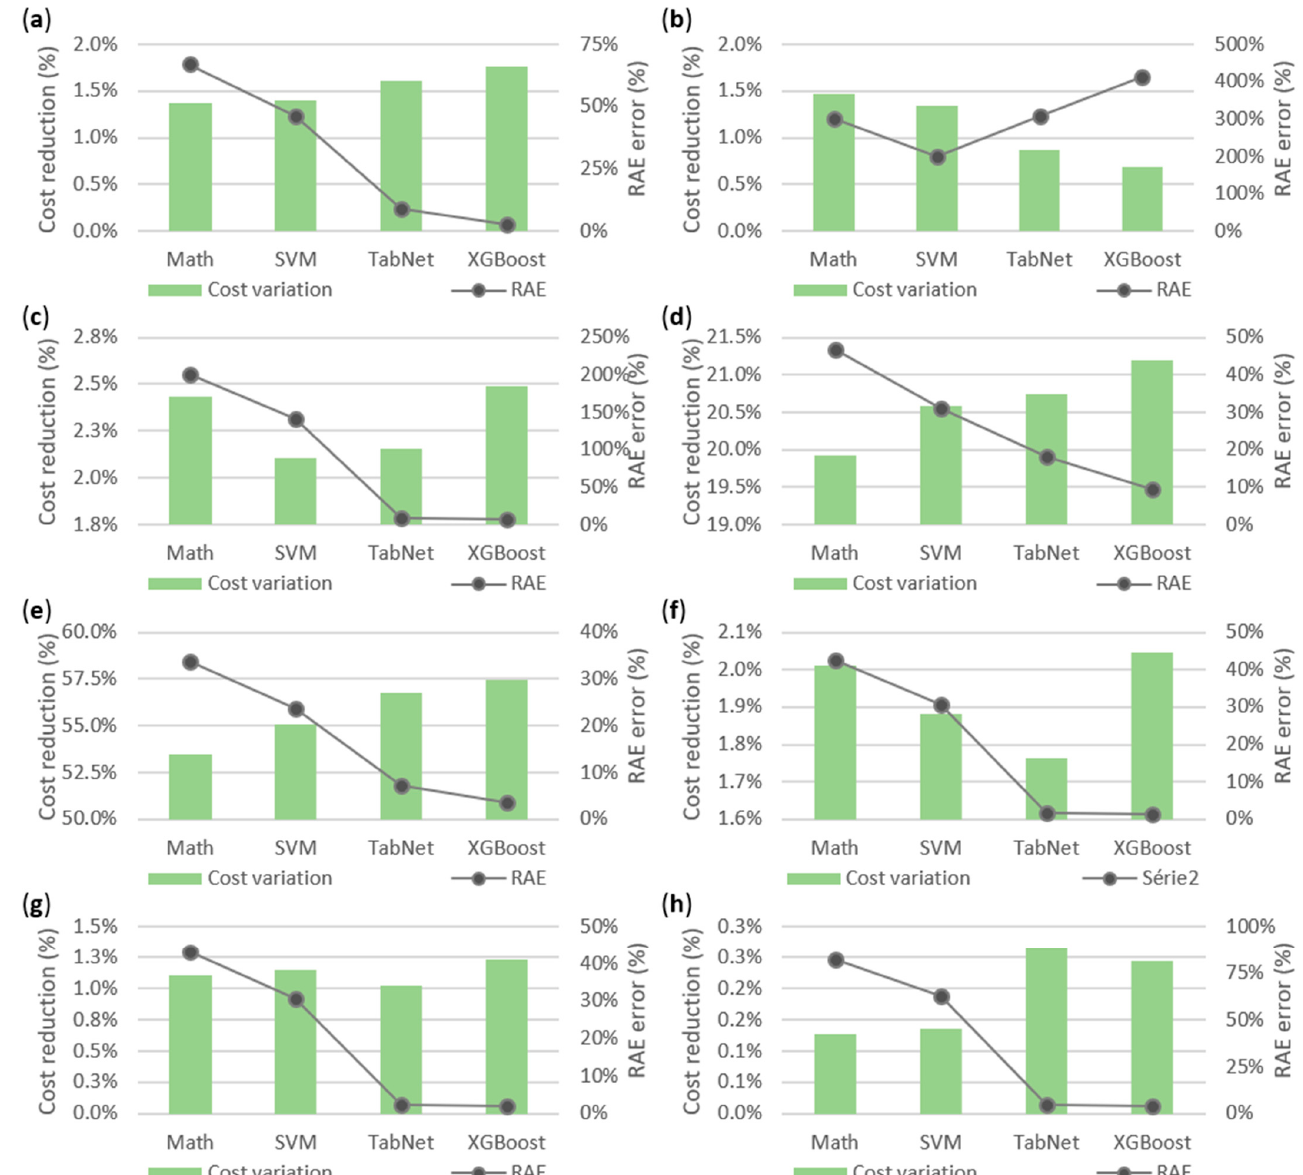
Figure 7. Relation between forecast errors (RAE) and energy cost reduction: ( a ) Agent 1, ( b ) Agent 2, ( c ) Agent 3, ( d ) Agent 4, ( e ) Agent 5, ( f ) Agent 5, ( g ) Agent 6, and ( h ) Agent 8.